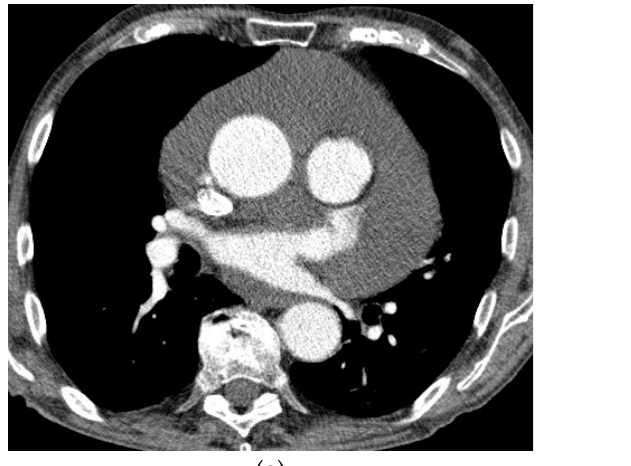
Figure 2. ( a , b ) Chest CT with contrast enhancement shows a large pericardial effusion. Chest MRI